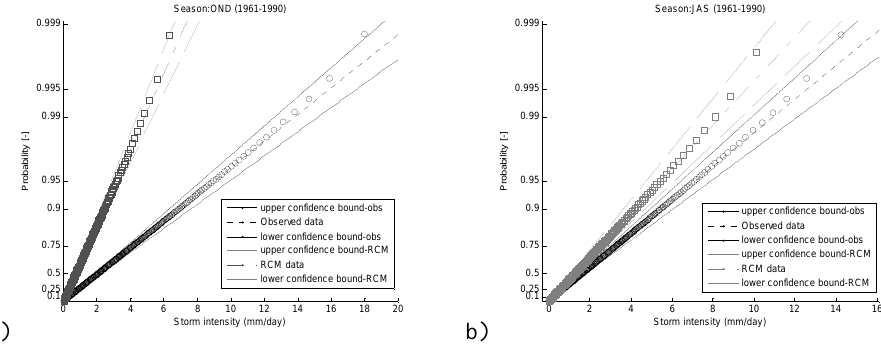
Figure 3. Exponential probability plots for the storm intensities computed from the reference observations (with circles) and the RCM (with squares), using data from a single grid-cell. Straight lines represent the corresponding theoretical distributions with their respective 95% confidence bands for autumn storm intensities (a) and summer storm intensities (b) .